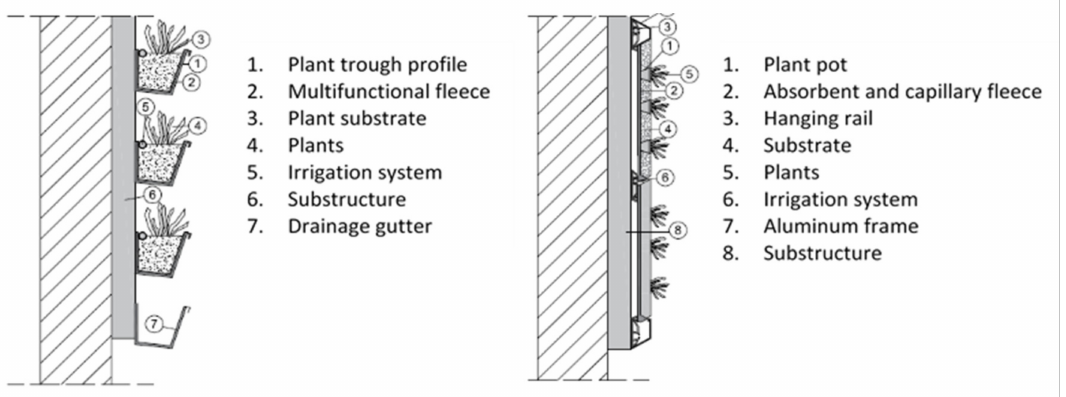
Figure 3. Structure of the systems; System A—aluminum troughs ( left ), System B—cassette sys- tem ( right